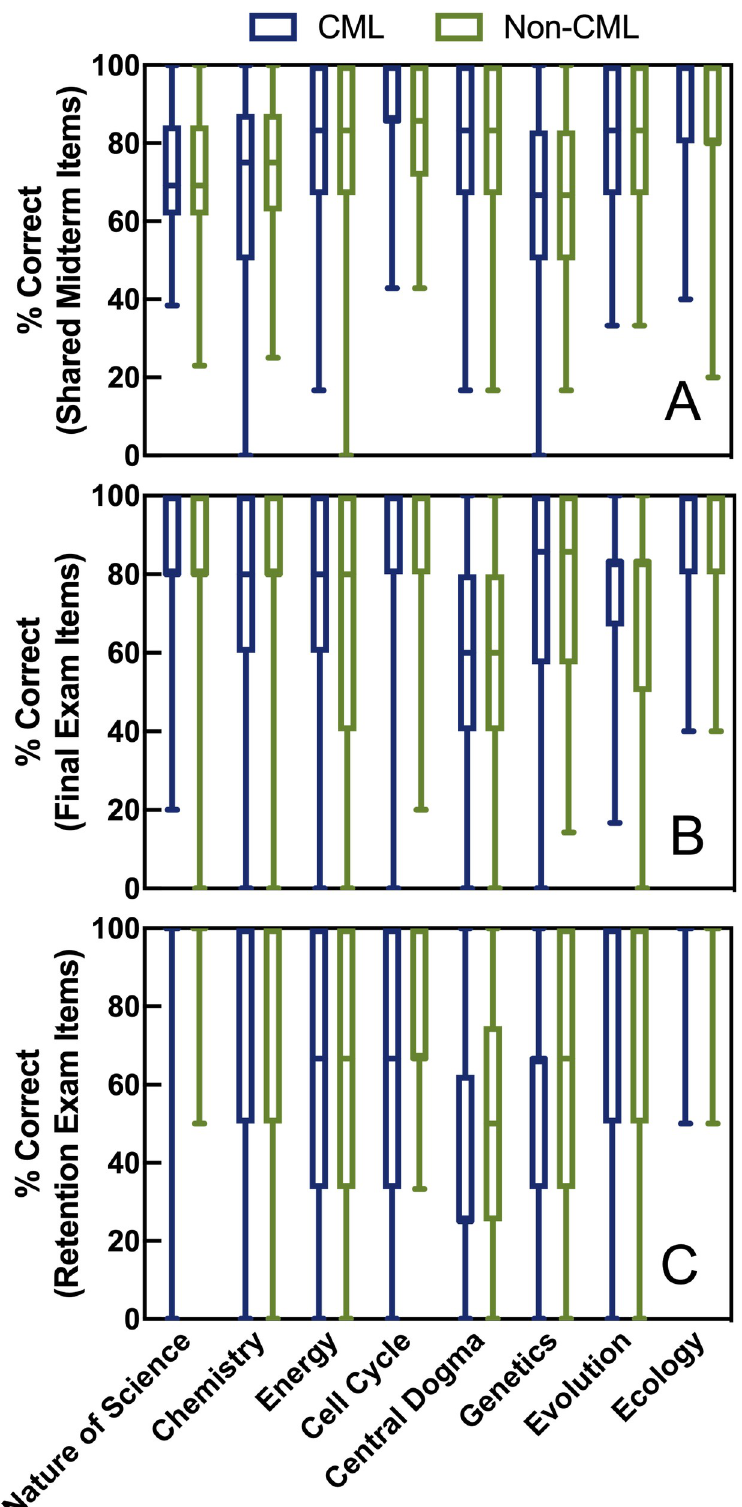
Fig 6. Effect of cumulative midterms on early versus late course topics. Student performance on shared midterm items (Panel A), final exam (Panel B), and retention exam (Panel C) are shown on the y axes by treatment